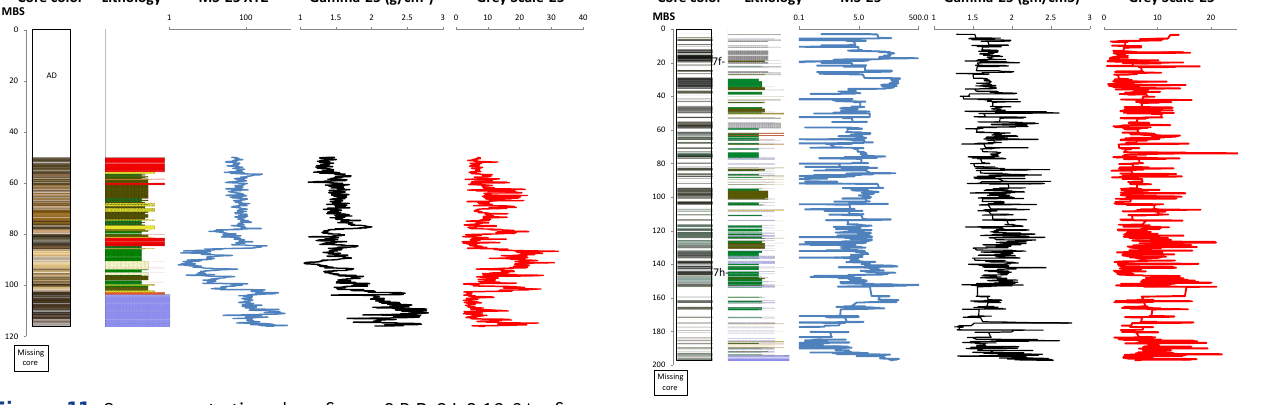
Figure 11. Summary stratigraphy of core ODP-OLO12-3A, from the Koora Plain/Olorgesailie drilling area, southern Kenyan Rift Valley, based on initial core description results. Columns from left to right: core color stratigraphy; lithologic log; see Fig. 5 for the key to lithologies used in all cores illustrated; composite of magnetic susceptibility (MS) log data (25-point running mean smooth) from LacCore Geotek © XYZ point sensor data; composite of induced gamma density log data (25-point running mean smooth, spurious values <1.0gmcm − 3 removed); composite of spectrophotometric grey-scale log data (25-point running mean smooth). AD: augered drilled interval: sediment bagged and collected at Site 1, and not collected at Site 3. All other data collection, instrumentation, and parameters as in Fig. 5.